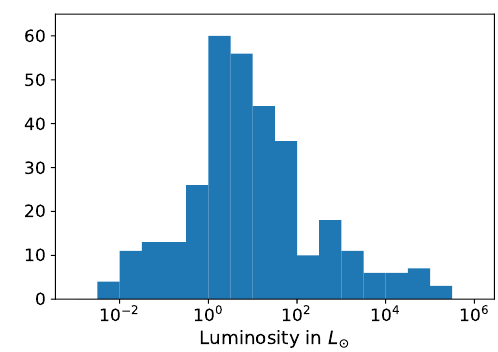
Fig. 25.— Automatically-generated histogram